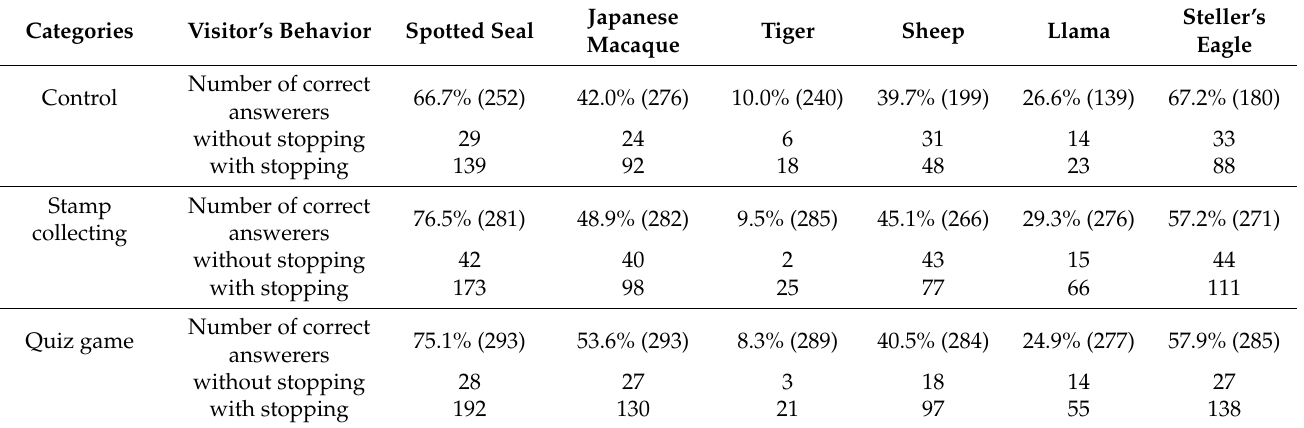
Table 2. Percentage of questions answered correctly and behavior.